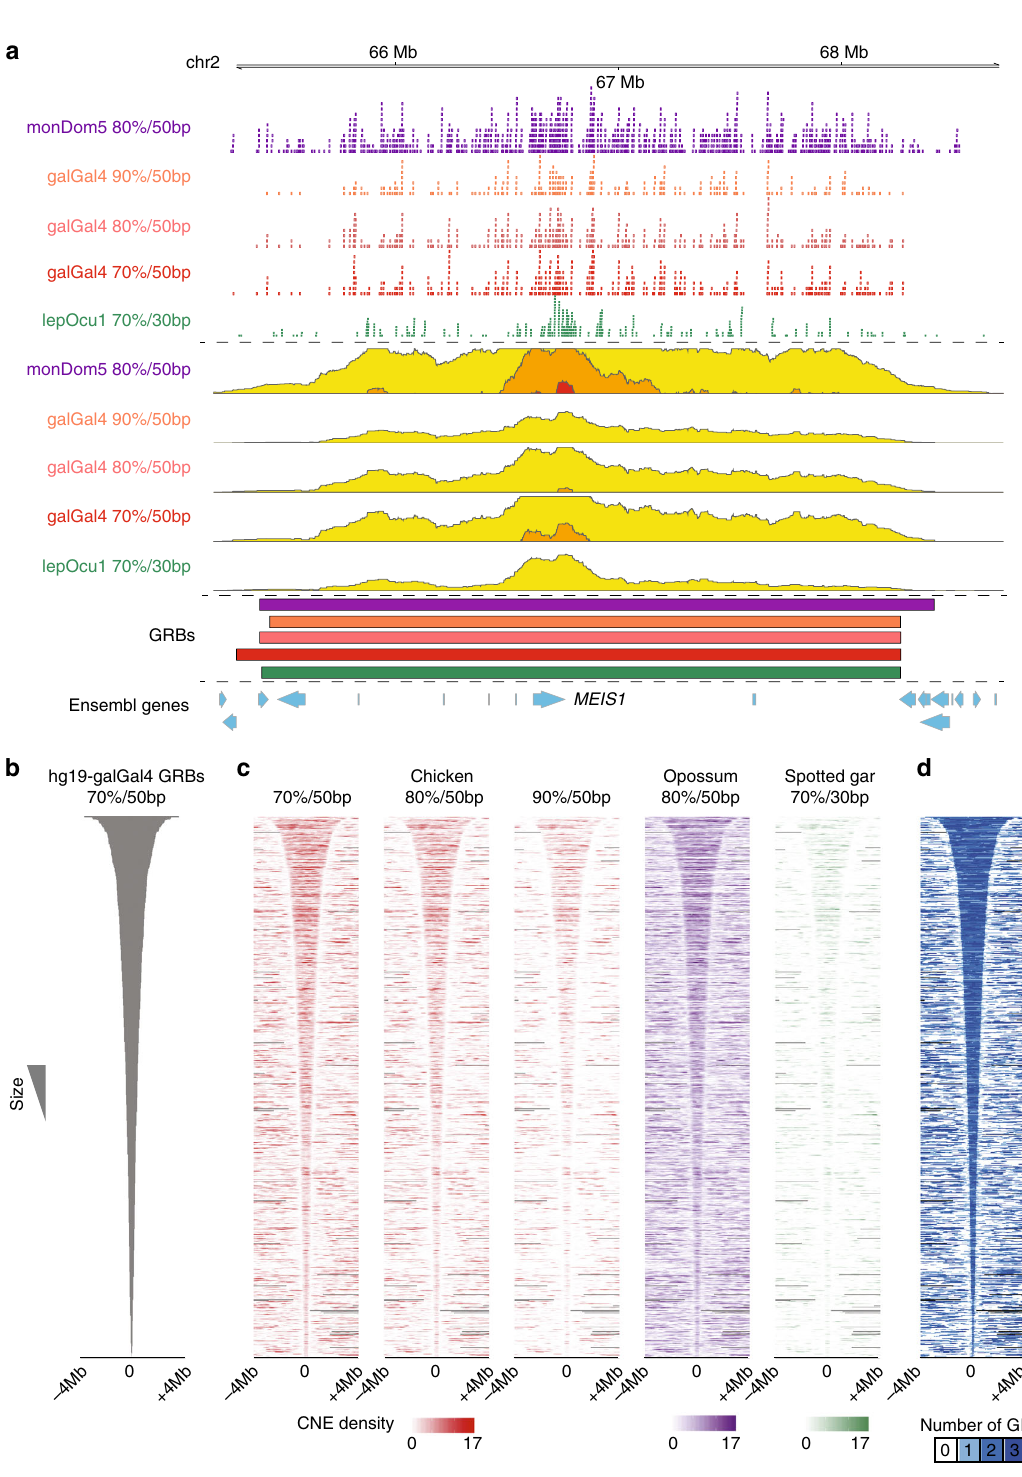
Fig. 1 The boundaries of GRBs are highly consistent regardless of the thresholds or species involved. a The human MEIS1 locus is spanned by arrays of conserved noncoding elements (CNEs) identi fi ed in comparisons with opossum, chicken and spotted gar. These CNEs can be visualised as a smoothed density, shown here as a horizon plot . The boundaries of the proposed GRBs at the MEIS1 locus are highly consistent regardless of the species or thresholds involved. b All hg19-galGal4 GRBs centred and ordered by length of the GRB. c Distribution of CNEs in a window of 8 Mb around the centre of the hg19- galGal4 GRBs for different sets of CNEs. d Overlap of putative GRBs obtained using comparisons between hg19-monDom5 and hg19-lepOcu1 with these sets of GRBs identi fi ed using CNEs using hg19-galGal4 (70%/50